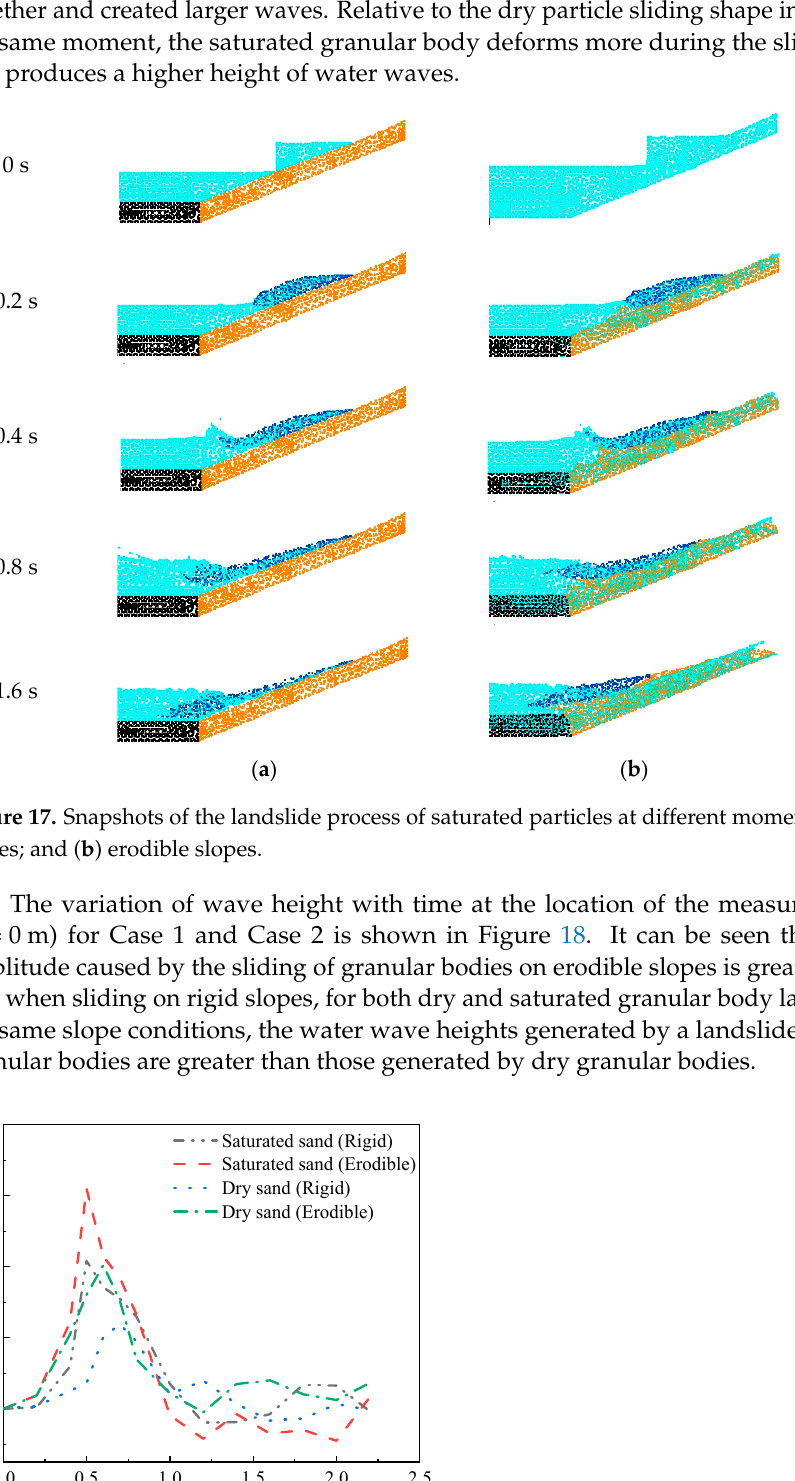
Figure 16. Snapshots of the landslide process of dry particles at di ff erent moments on ( a ) rigid slopes; and ( b ) erodible slopes.